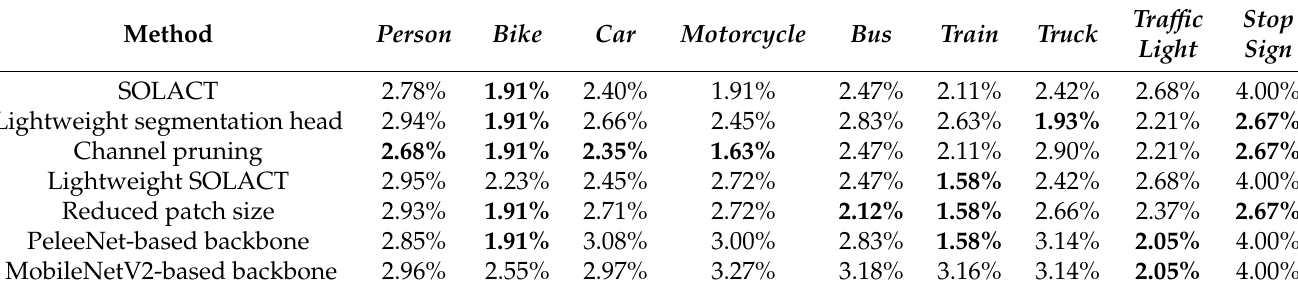
Table 4. False positive detections ( ↓ ) of the proposed architectures over the COCO validation set